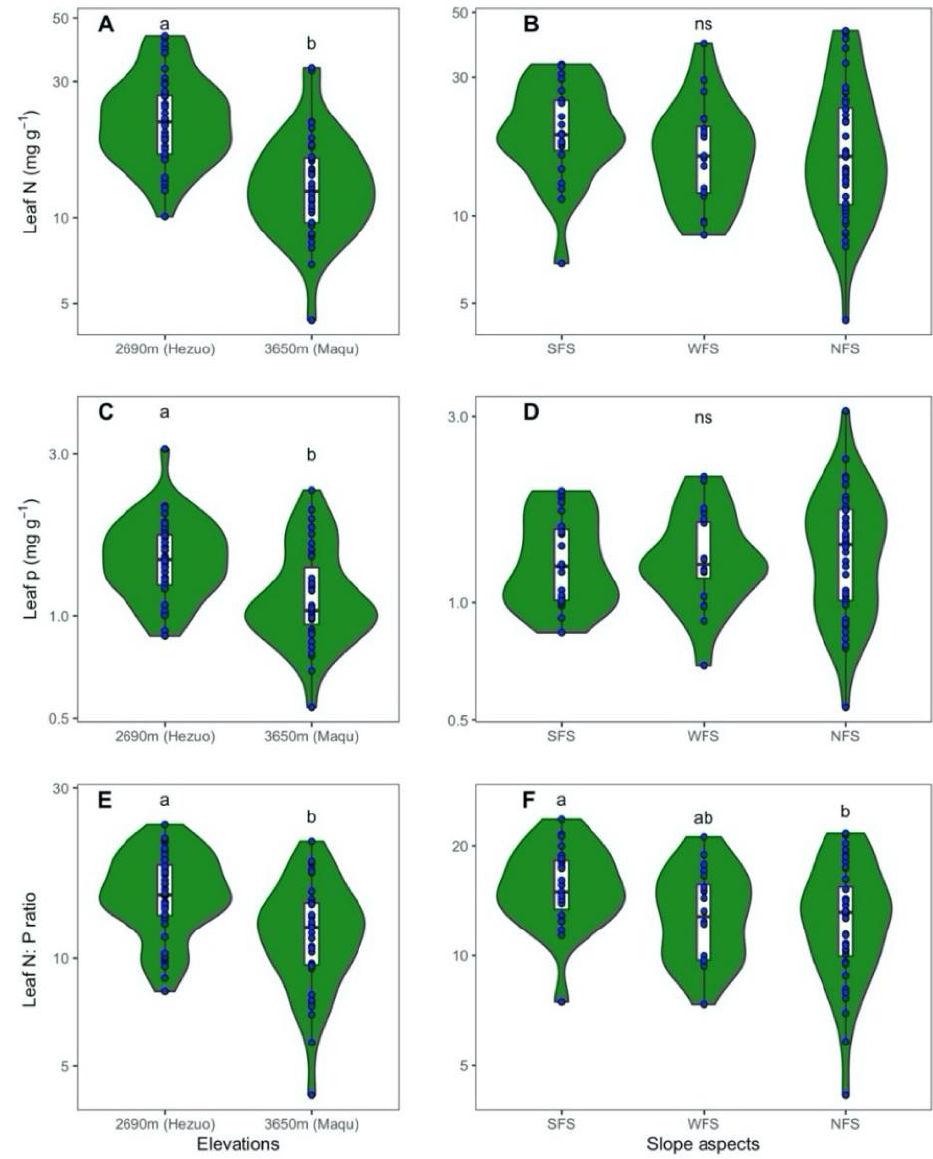
Figure 2. Comparisons of leaf [N] ( A , B ), [P] ( C , D ), and N:P ratio ( E , F ) between sites and among slope aspects. SFS, WFS, and NFS represent south-, west-, and north-facing slope aspects, respectively. Different letters represent significant differences at the level of p < 0.05. Variables are in log10 scale.